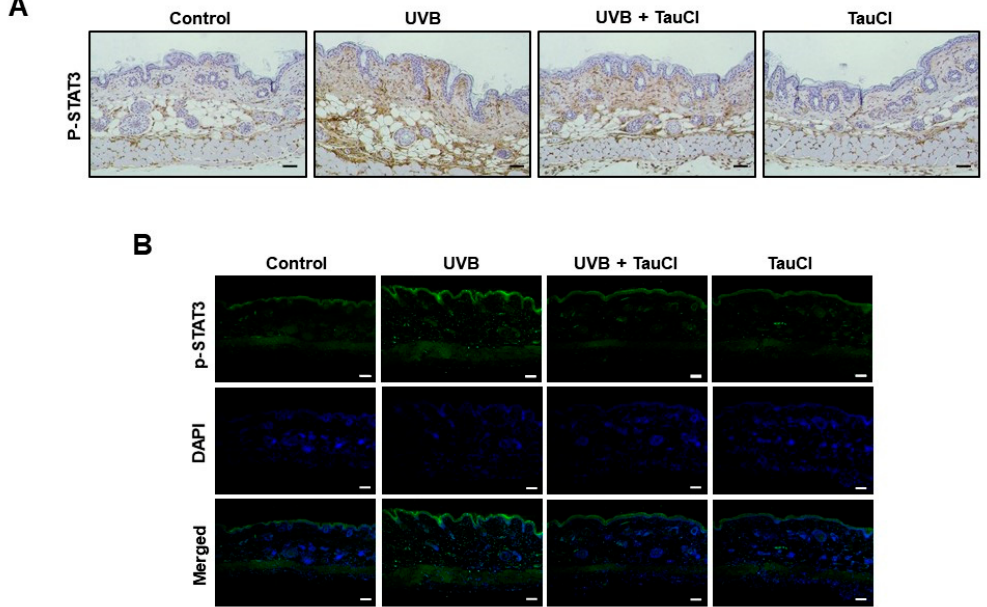
Figure 4. Topically applied TauCl attenuated UVB-induced phosphorylation of STAT3 in mouse skin. ( A , B ) Expression of P-STAT3 was measured by immunohistochemical analysis ( A ) and immunofluorescence staining ( B ). Scale bar, 200 μ m.